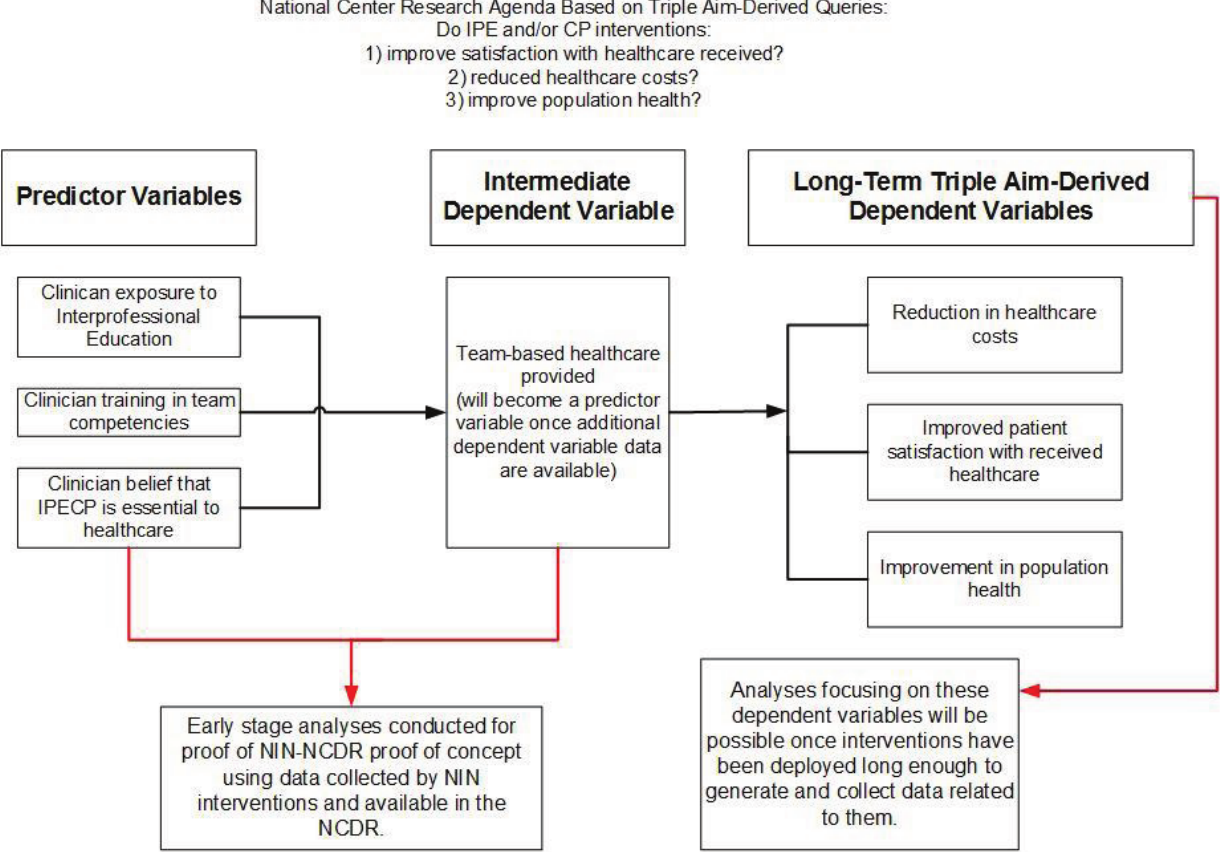
Figure 2. Proof of concept analyses in context of long-term analyses